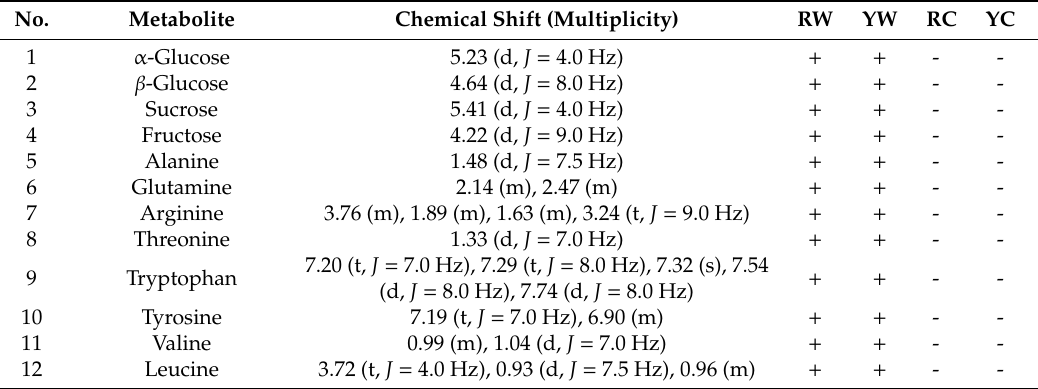
Table 1. Identified metabolites in red and yellow watermelon cultivars using two types of nuclear magnetic resonance (NMR) solvent (R: red watermelon, Y: yellow watermelon, W: deuterium oxide, C: deuterated